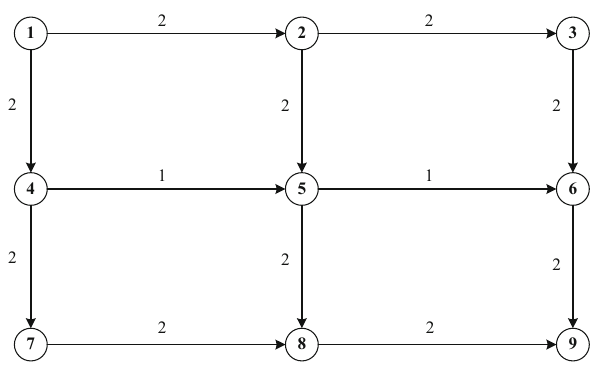
Fig. 2 Grid network with link